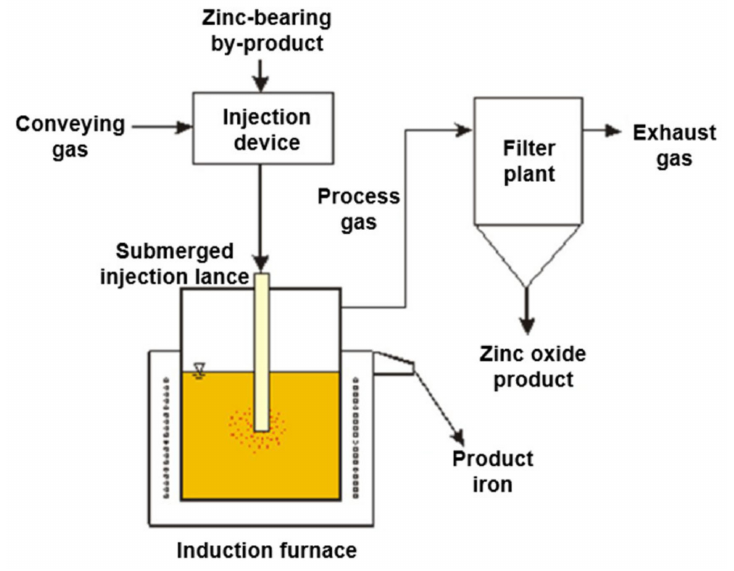
Figure 5. Scheme of the melt bath injection process [18].